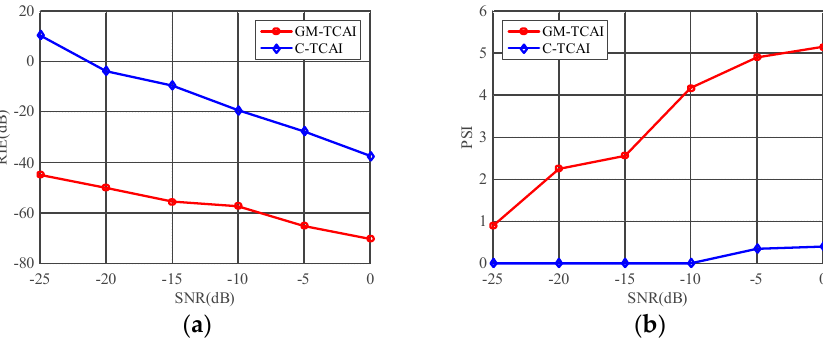
Figure 9. Imaging evaluations of C-TCAI and GM-TCAI using: ( a ) the relative imaging error (RIE); and ( b ) the probability of successful imaging (PSI), at various SNRs for extended targets.